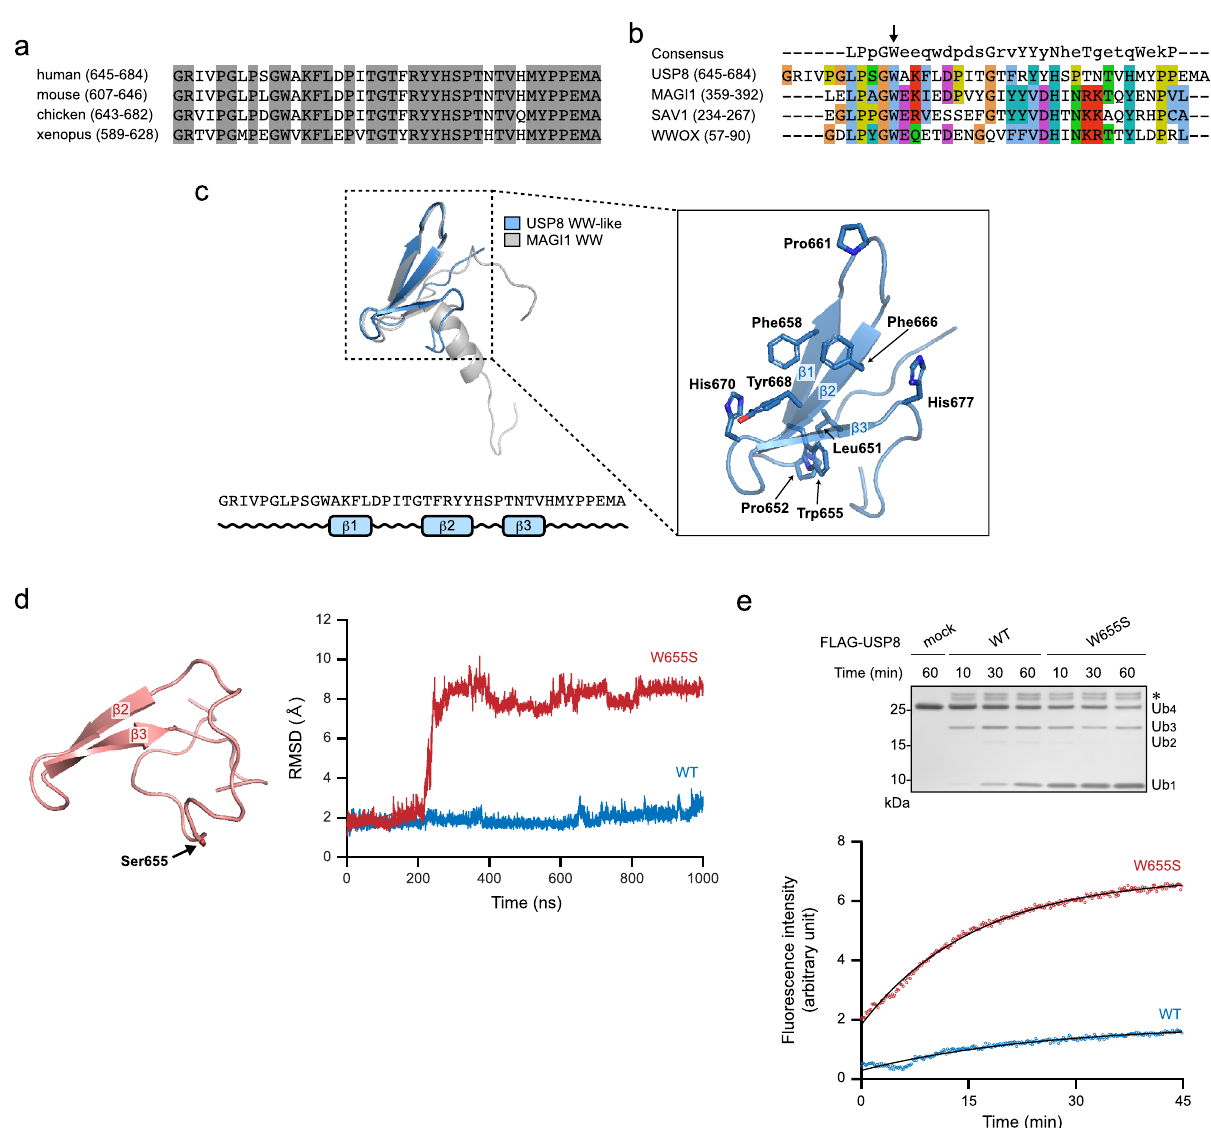
Fig. 2 Structural modelling of the USP8 autoinhibitory region. a Amino acid sequence conservation among vertebrates. Grey highlighting: conserved residues. b Sequence similarity to the atypical WW domains of MAGI1, SAV1 and WWOX. The arrow indicates the conserved N-terminal tryptophan. The consensus sequence of the WW domain is also shown. c A structural model of the WW-like domain. Left, superposition of the predicted model (blue) and MAGI1 WW domain (grey) as well as the secondary structure based on the model. Right, magni fi cation of the hydrophobic surface formed by three antiparallel β -sheets. d Molecular dynamics simulations of the predicted model and Trp 655 to Ser (W655S) mutant. Left, the simulation structure of the W655S mutant. Right, the root mean square deviations (RMSD) from the predicted structure as a function of simulation time. Blue, WT. Red, W655S mutant. e Deubiquitination activities of USP8 W655S . Top, ubiquitin chain cleavage assay by similar methods to those described in Fig. 1c. *, copuri fi ed protein (s) with USP8. Bottom, ubiquitin-AMC assay. HEK293 cells expressing USP8 W655S were lysed. Anti-FLAG immunoprecipitates were subjected